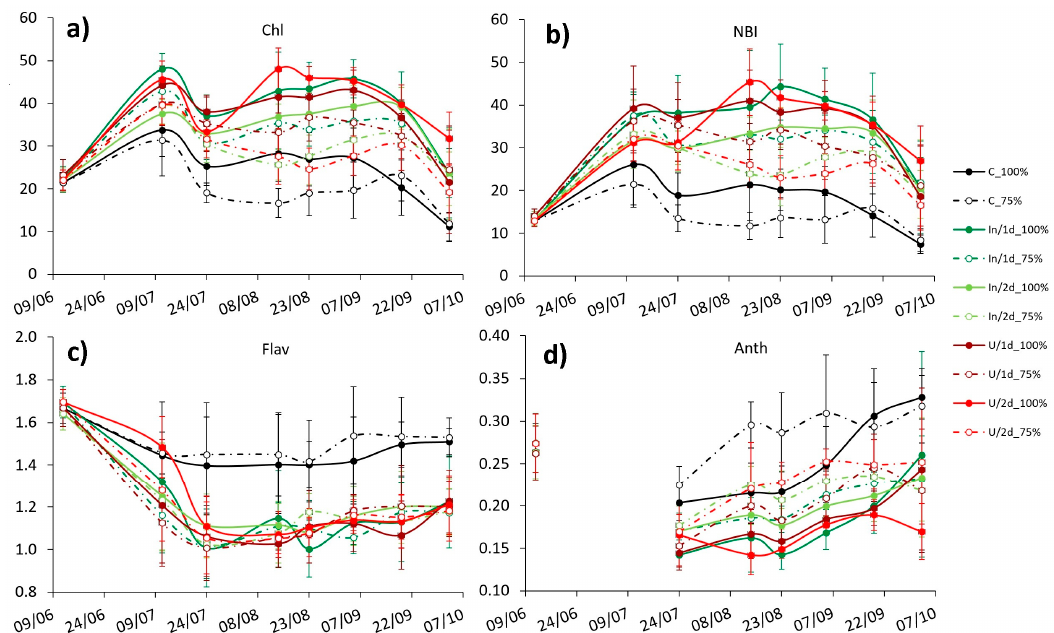
Figure 1. ( a ) Chlorophyll (Chl), ( c ) flavonol (Flav), ( d ) anthocyanins (Anth), and ( b ) NBI indexes (dimensionless) estimated with the Dualex ® for the different treatments along the maize cycle. Arrows represent the two fertilizer dressings. Bars represent the standard error. Treatments were a combination of urease inhibitor use (In), simple urea use (U), or no fertilizer (C), with fertilizer application in one (1 d) or two (2 d) dressings and optimally irrigated (100%) or sub-optimally irrigated (75%).